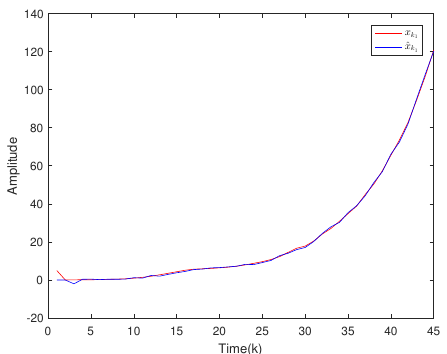
Figure 9. The state evolutions of x 1, k and corresponding estimates ˆ x 1, k .